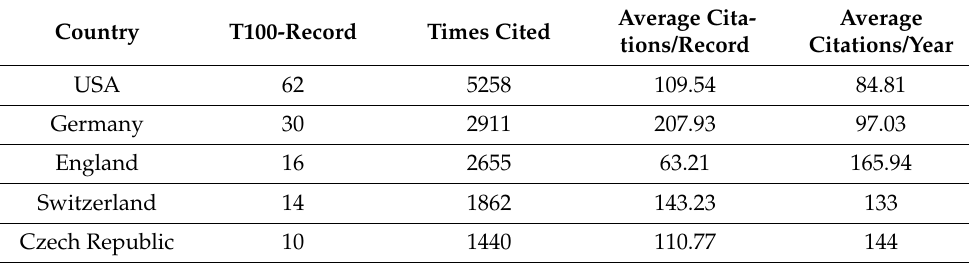
Figure 2B and Table 3 show the geographic distribution of the T100 list of papers. The highest ranking country was the USA, with 62 articles (5258 citations, 84.81 cita- tions/article and 109.54 citations/year), including 8 of the top 10 (T10). Germany, with 2911 citations (50% lower than the USA), placed second. Table 3. Countries publishing more than 10 of the T100 cited articles.